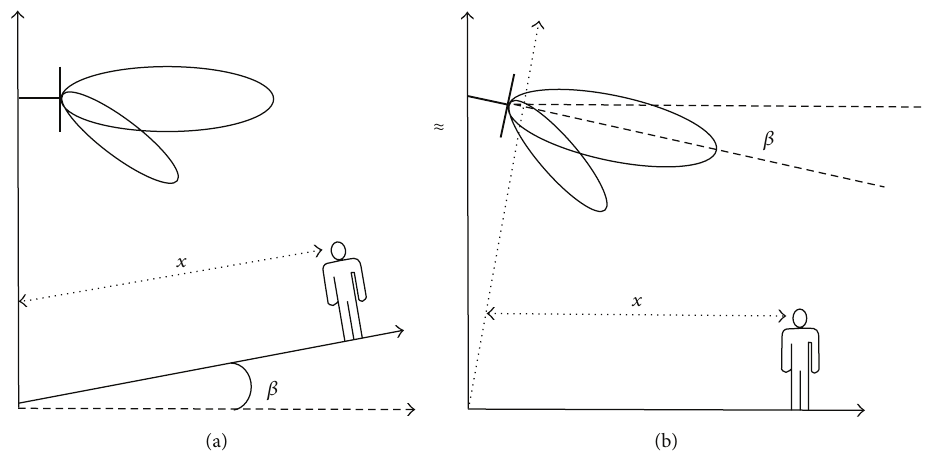
Figure 4: Approximation of a sloped path by a plane path with tilted antenna. (b) is not exactly equivalent to (a) because the 𝑦 -axis should also be rotated by 𝛽 degrees. However, the error introduced by this assumption is small compared to the estimated maximum exposure location.